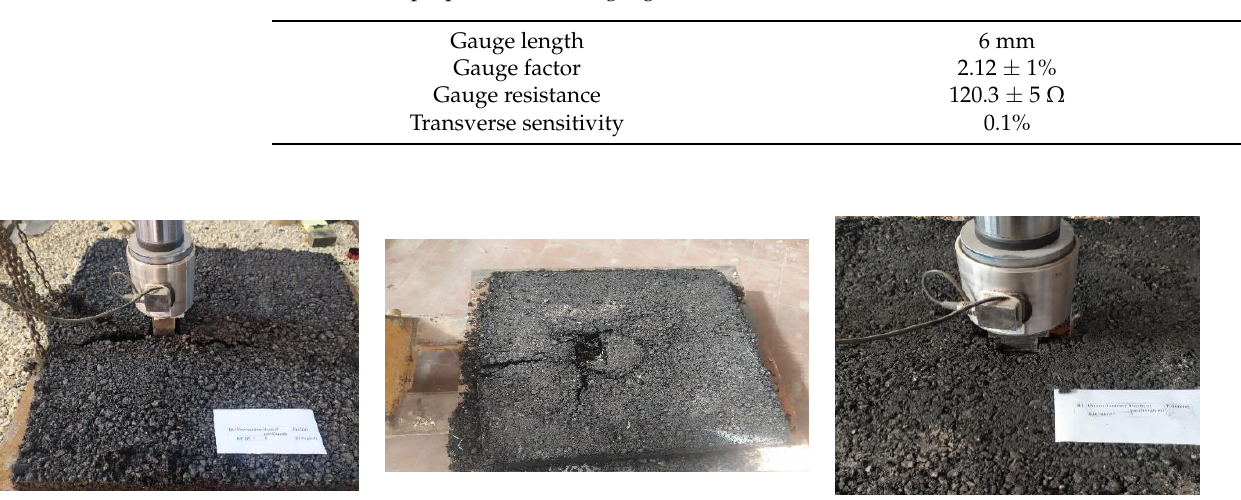
Figure 6. Marked potholes after loading.